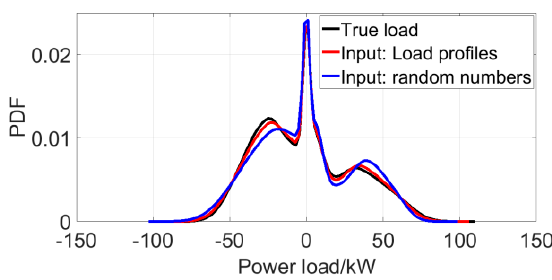
Figure 14. Probability density function of PHEV_DR.